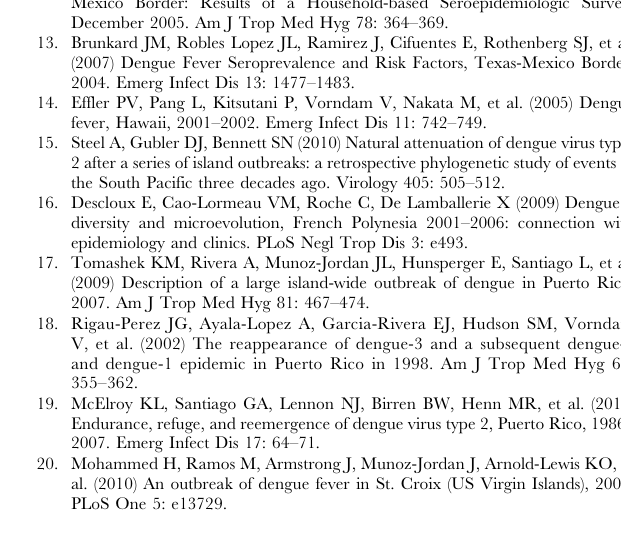
Table S1 DENV E gene amplification and sequencing primers. List of all primer sequences used for E gene amplification and sequencing. Corresponding serotype, specific primer function and final concentration per reaction are indicated. Every primer is labeled with serotype and genome position. Reverse primers are labeled (cD). Table S2 Performance of the CDC DENV-1–4 Real Time RT- PCR Assay using different viral RNA extraction methods. Viral RNA from serial dilutions of stock quantitated DENV-1–4 was extracted using several viral RNA extraction kits. The lowest virus titer detected is indicated in genome copy equivalents per mL